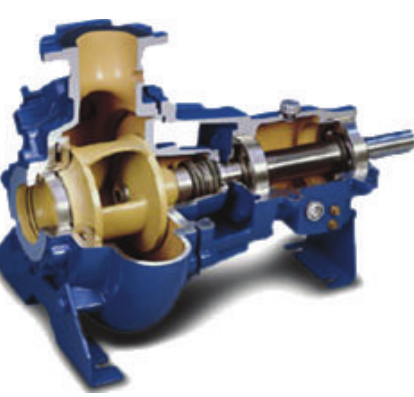
Figure 15: Commercial single-blade pump (cid:5) 17 (cid:6) .